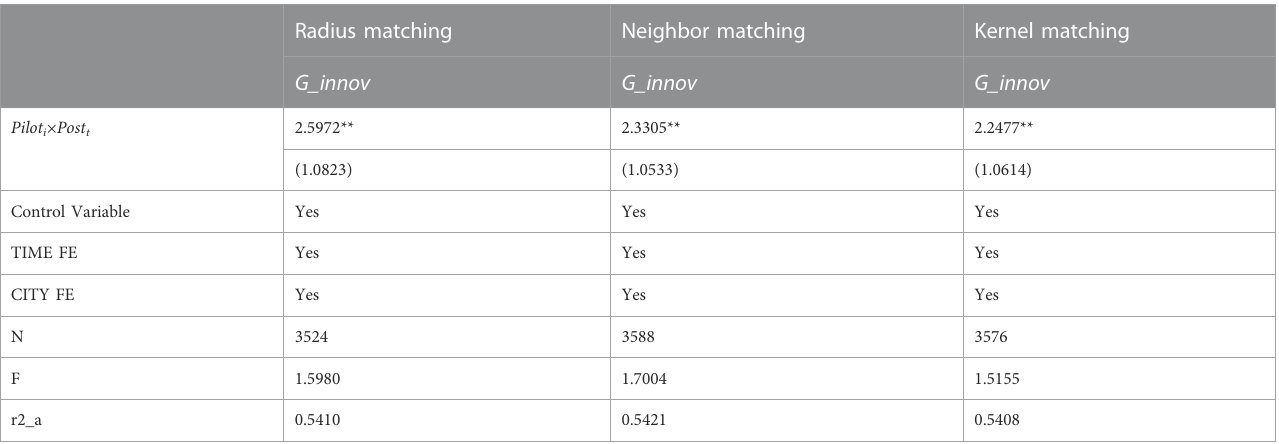
TABLE 3 PSM-DID regression results.